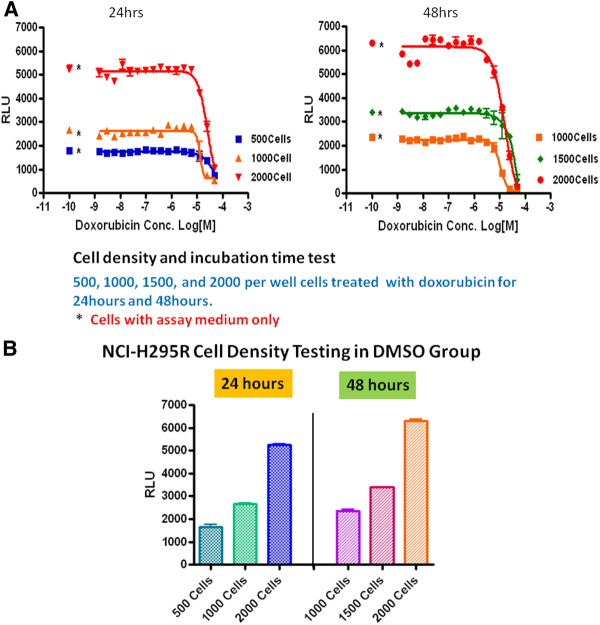
A) NCI-H295R cell density testing for quantitative high throughput screening. At 1,500 cells per well, the optimal dose–response curve was observed. B) At 2,000 cells per well, cellular proliferation was observed in DMSO treated NCI-H295R cells.